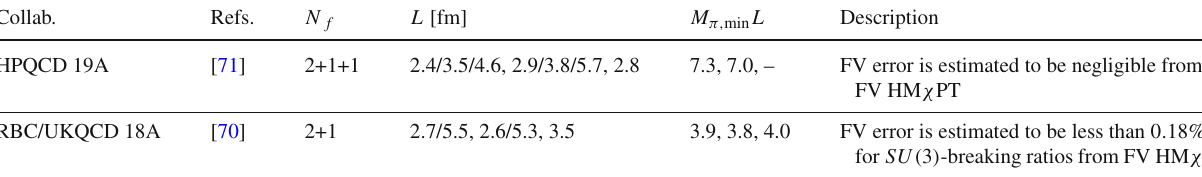
Table 152 Finite-volume effects in determinations of the neutral B -meson mixing matrix elements. Each L -entry corresponds to a different lattice spacing, with multiple spatial volumes at some lattice spacings. For actions with multiple species of pions, masses quoted are the RMS pion masses (where available) Collab.